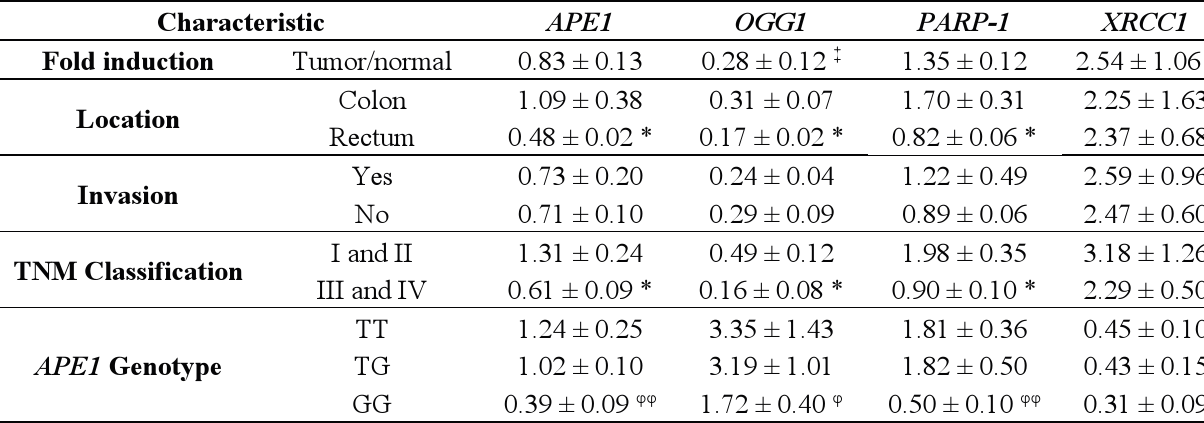
Table 3. Gene expression according to sample